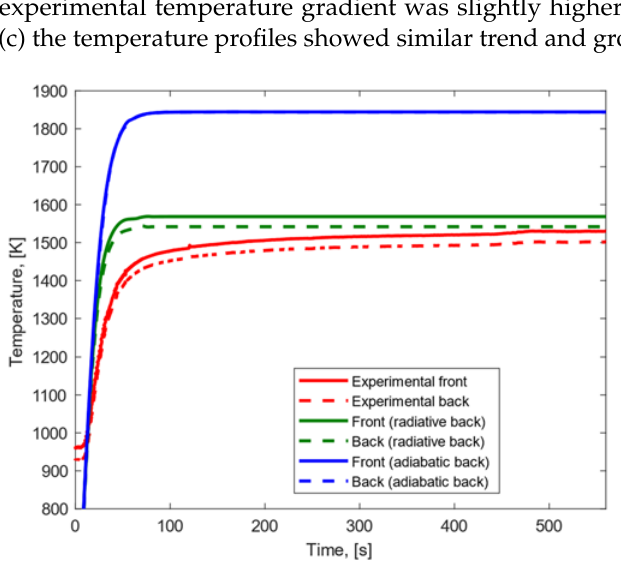
Figure 11. Experimental and modeling temperature profiles for silicon carbide subjected to high heat flux.